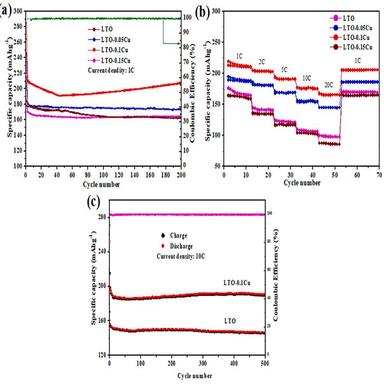
Cycle performance (a) and rate capacities (b) of the LTO, LTO-0.05Cu, LTO-0.1Cu and LTO-0.15Cu composites. (c) Long cyclic property of the LTO-0.1Cu hybrid.